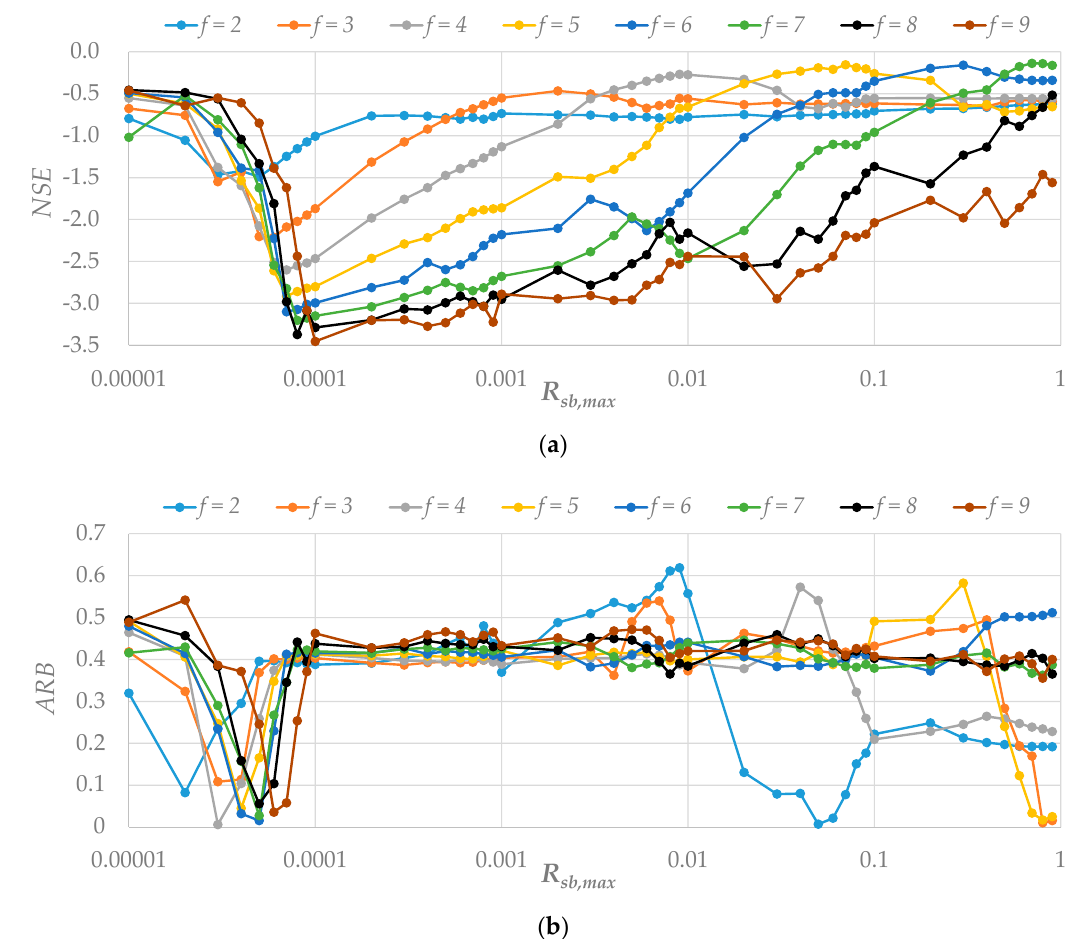
Figure 6. Comparison of the model performance evaluation results for assessing the goodness of fit by ( a ) the Nash–Sutcliffe efficiency ( NSE ); and ( b ) the absolute value of the relative bias ( ARB ) with respect to the hydraulic conductivity decay factor f and the maximum baseflow coefficient R sb ,max in the baseline CoLM for total runoff during 2009 at the Jindong stream gauge station in the study watershed.